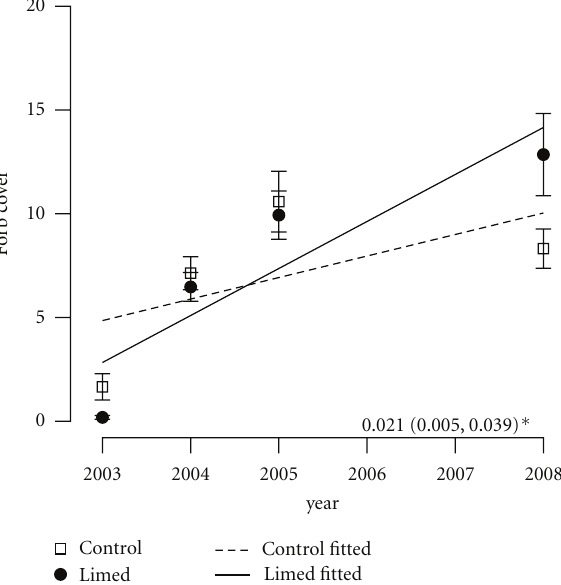
Figure 3: Mean percent understory coverage of forbs with SE bars and model lines on lime-treated and control sites. Lime treatment was applied between 2003 and 2004 in central Pennsylvania. ∗ Confidence intervals of the time-by-treatment interaction ex- cluded zero, indicating a significant e ff ect of liming on that